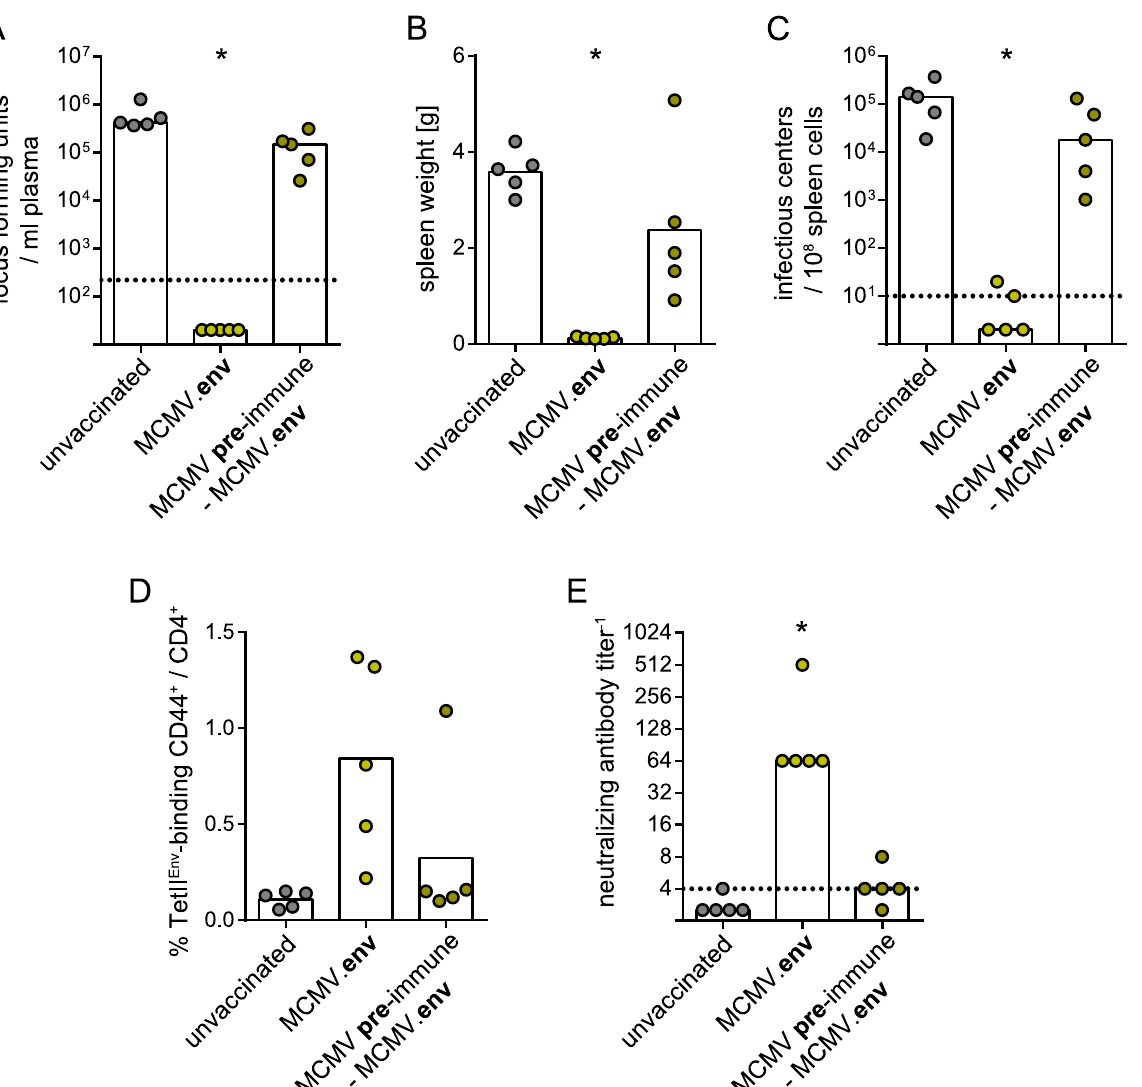
Fig 13. Immunization in pre-existing MCMV-specific immunity. CB6F1 mice were once immunized with MCMV.env, with or without one injection of non-transgene-encoding MCMV five weeks before. Six weeks after MCMV.env immunization, mice were infected with 5 000 SFFU FV. Viral loads in plasma were analysed ten days after FV infection (A), spleen weights (B) and spleen viral loads (C) were analysed three weeks after FV infection. The Env-specific CD4 + T cell response was analysed two weeks after MCMV.env immunization (D), F-MuLV neutralizing antibody titers were analysed ten days after FV infection (E). Data were obtained in one experiment, each dot indicates one mouse, bars indicate median (A, C, E) or mean values (B, D), dotted lines indicate the limits of detection. Statistically significant differences compared to unvaccinated mice are indicated by � ( P < 0.05, One Way ANOVA on Ranks, Dunn’s post